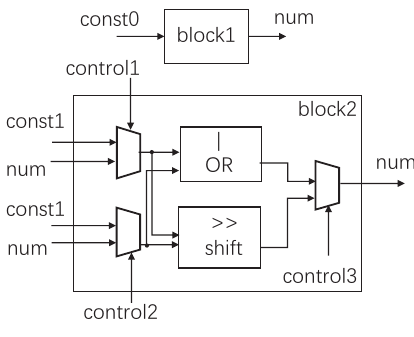
Figure 2. The schematic of block1 and